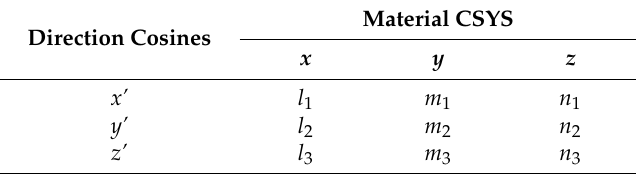
Table 1. Direction cosines between coordinate axes in the different coordinate